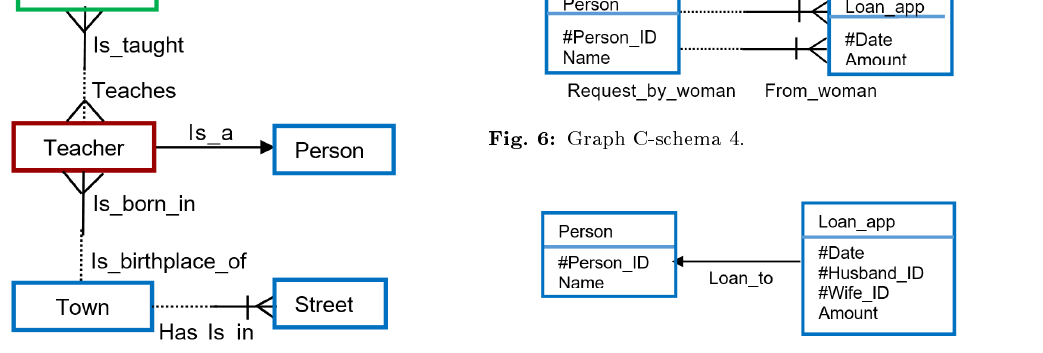
Fig. 4: Graph C-schema 3.